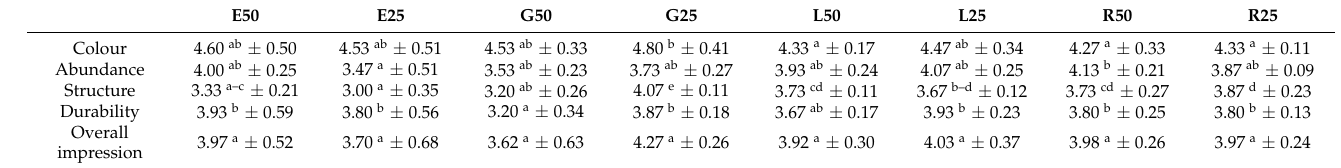
Table 5. Analysis of the quality characteristics of beer foam in Witbier